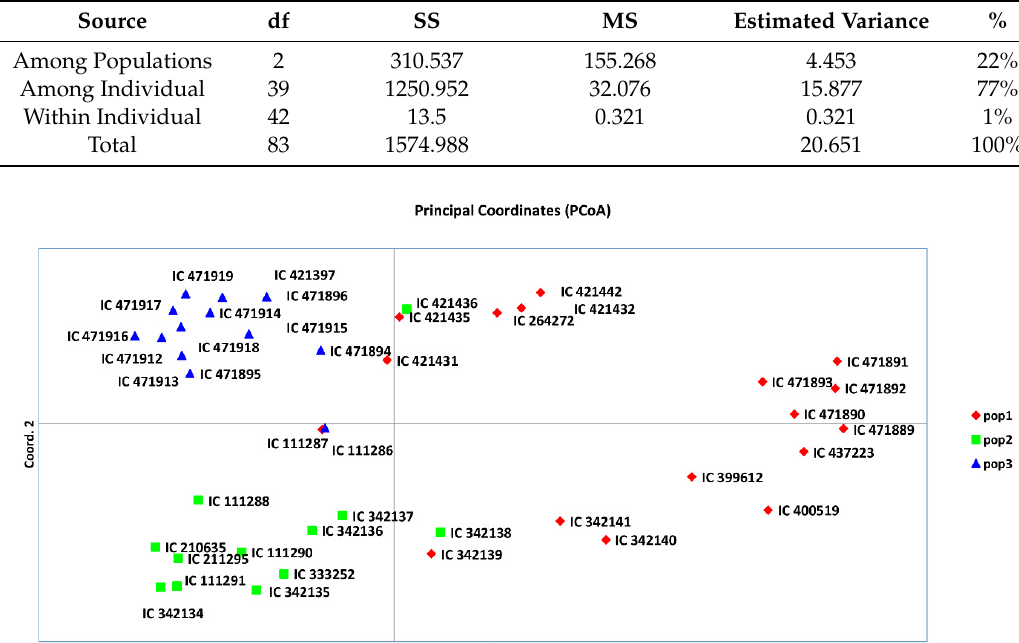
Figure 6. Principal coordinate analysis (PCoA) based on model-based population